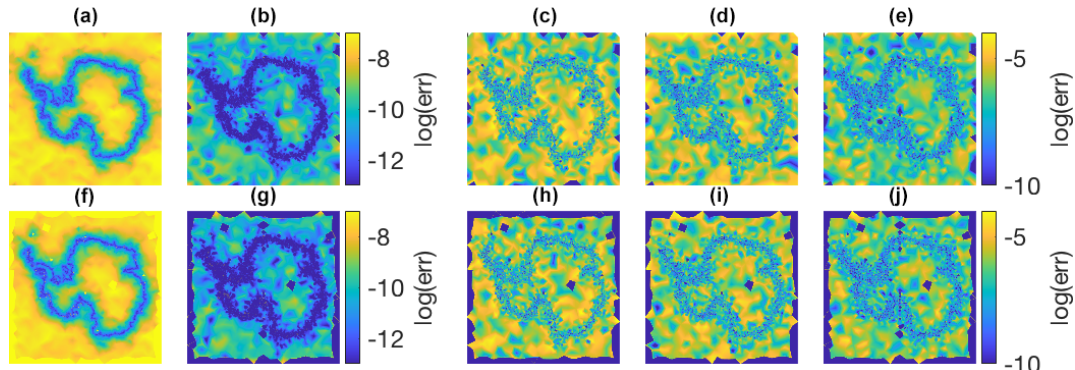
Figure A4. (a–e) Discretization errors for the averaged-gradient approach used in UFEMISM for, from left to right, f x , f y , f xx , f xy , and f yy . (f–j) The same for the least-squares approach from Syrakos et al. (2017).